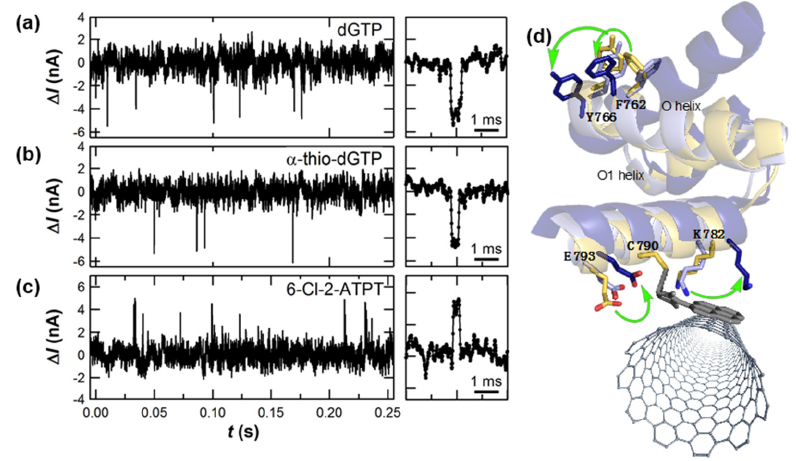
Figure 6. Direct comparison of nucleotide incorporation events into poly(dC) 42 templates using: ( a ) native dGTPs; ( b ) α -thio-dGTP; and ( c ) 6-Cl-2-APTP. ( d ) Reversal of the excursion direction suggests that conformational accommodation of the latter analog is allosterically transmitted to the SWNT, perhaps through motions of the O-helix depicted here.